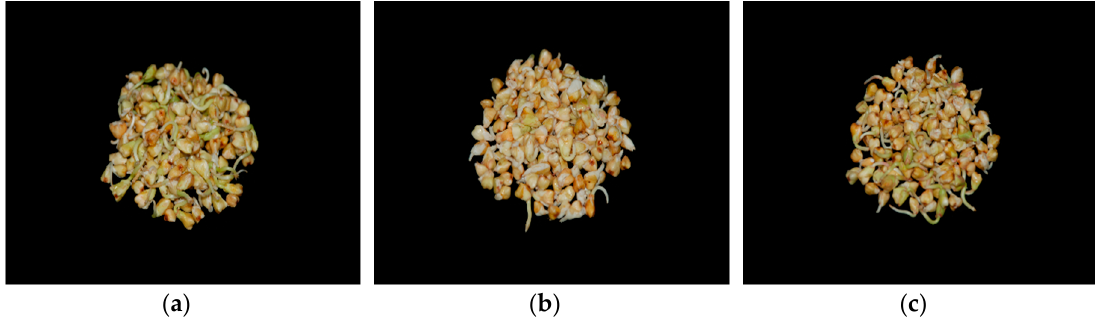
Figure 1. Buckwheat germinated for 72 h. ( a ) Control; ( b ) germinated buckwheat treated with 150 μ M jasmonic acid; ( c ) germinated buckwheat treated with 0.1% chitosan.